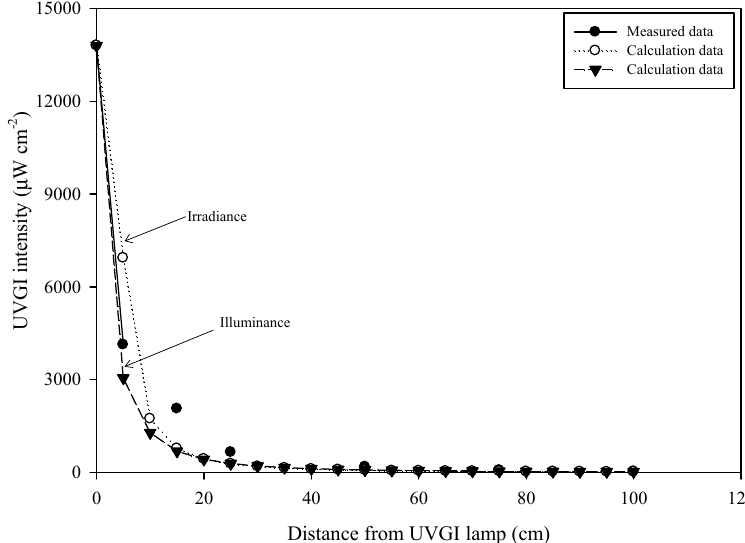
Figure3. Figure 3. Calculated data and measured data of UVGI intensity at various distances from the UVGI lamp.